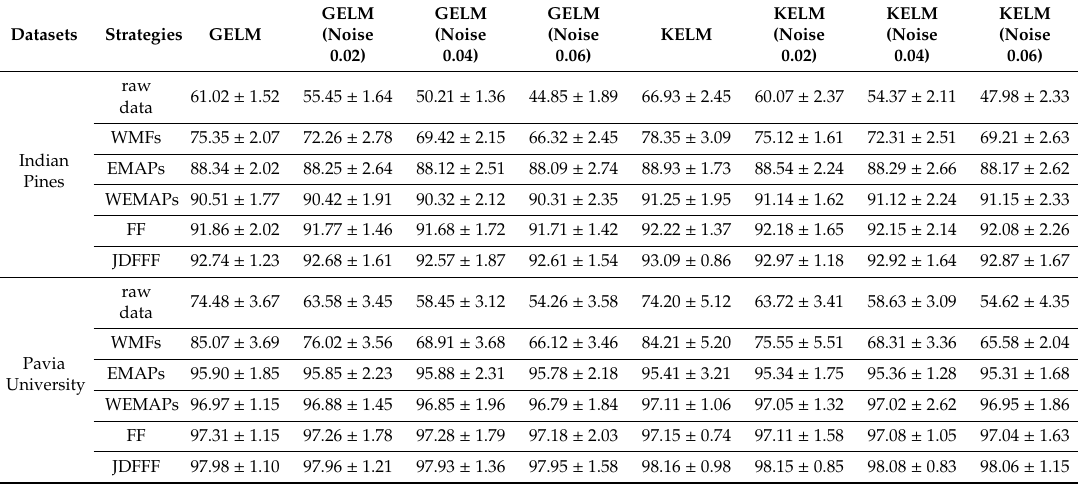
Table 2. The classification overall accuracies (in percentages) on these two datasets with 15 labeled samples per class for